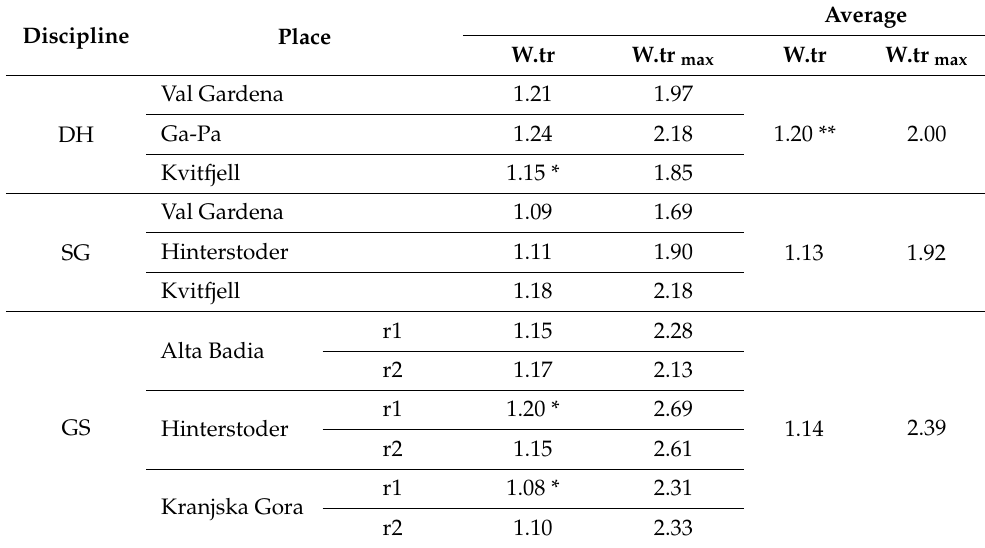
Table 1. Mean and maximum values of